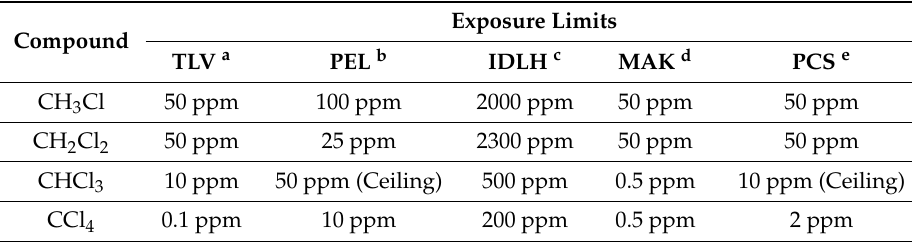
Table 3. Occupational exposure limits of